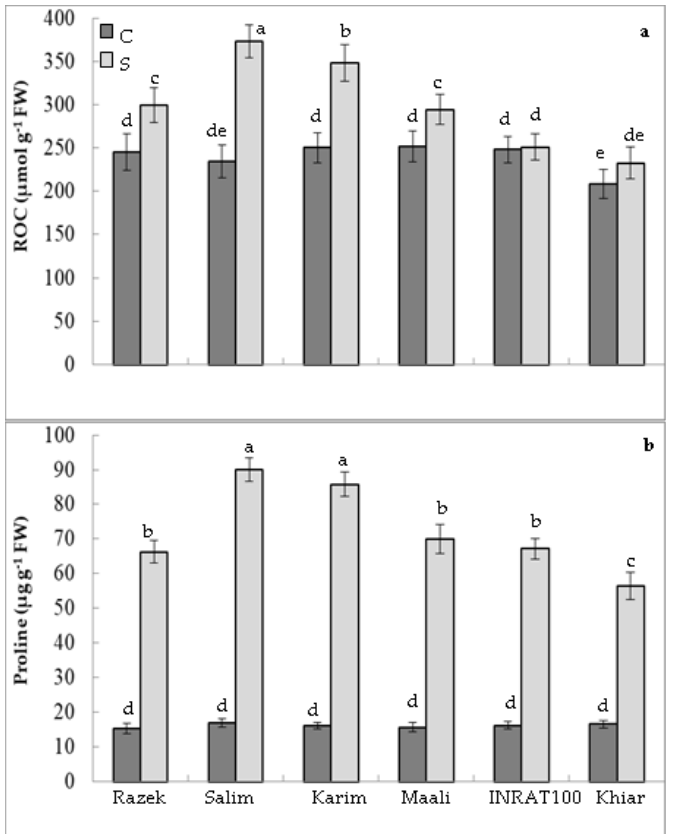
Figure 3. Relative osmolytes content (ROC, ( a )) and proline concentration ( b ) in of durum wheat ( Triticum durum Desf.) plants subjected (S, stressed) or not (C, control) to drought stress. According to Fisher’s least significant difference, within columns, means with the same letter are not significantly different at α = 0.05. Standard errors of means of 10 replicates.